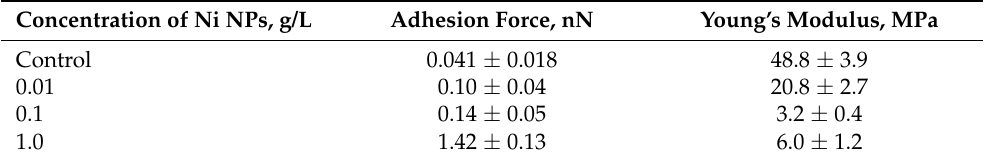
Table 2. Nanomechanical properties of R. ruber IEGM 231 cells after their 24-h incubation with Ni